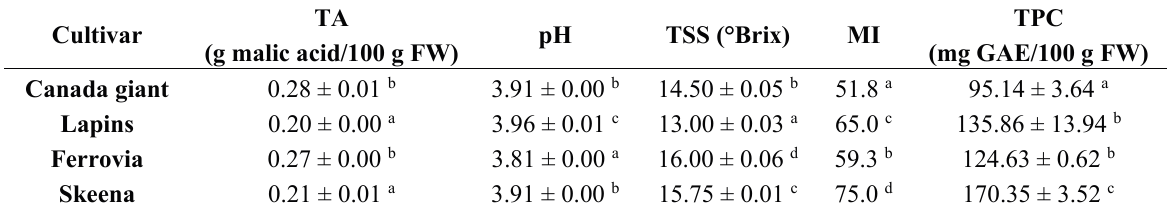
Table 1. Physicochemical parameter data of four sweet cherry cultivars. Cultivar